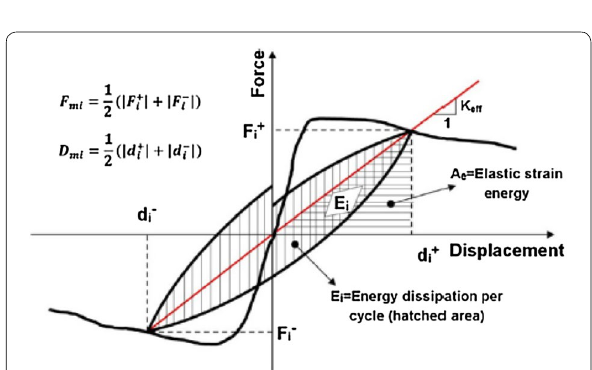
Fig. 22 Accumulative dissipated energy and secant stiffness for cyclic response (Shafaei et al. 2014).